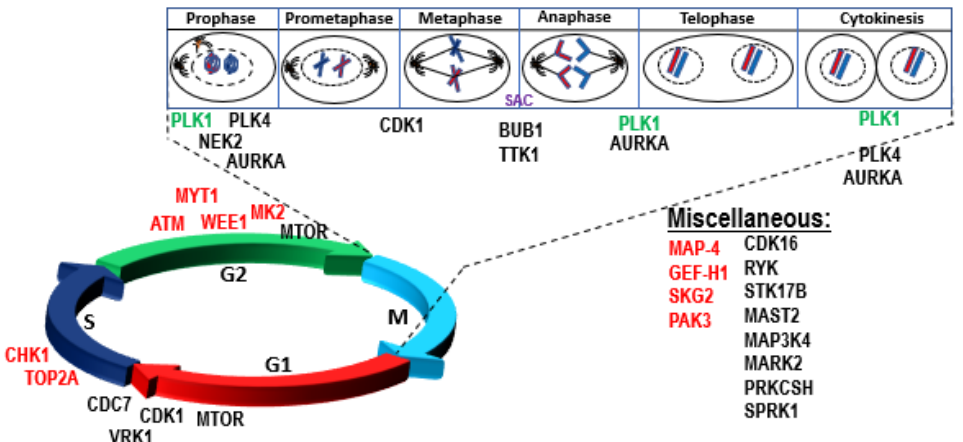
Figure 5. Synthetic lethal interaction of P53 with cell cycle and other genes and their distribution across cell cycle. Experimentally validated or detected in functional genomic screens (red), in silico predicted (black) and both (green). PLK1 = polo-kinase 1, ATM = ataxia telangiectasia mutated, GEF-H1 = guanine nucleotide exchange factor-H1, MK2 = MAP-kinase activated protein kinase 2, SGK2 = serine/threonine kinase, CHK1 = Serine/threonine-checkpoint kinase 1, MAP4 = microtubule-associated protein 4, MYT-1 = Membrane-associated tyrosine- and threonine-specific cdc2-inhibitory kinase, Wee1 = nuclear serine/threonine kinase 1, CDK16 = cyclin-dependent kinase 16, RYK = receptor-like tyrosine kinase, MTOR = mechanistic target of rapamycin, STK17B = serine/threonine kinase 17b, PLK4 = polo-like kinase 4, MAST2 = microtubule associated serine/threonine kinase 2, MAP3K = 4 mitogen-activated protein kinase kinase kinase 4, MARK2 = MAP/microtubule affinity-regulating kinase 2, CDK1 = cyclin-dependent kinase 1, NEK2 = NIMA (never in mitosis gene a)-related kinase 2, PRKCSH = protein kinase C substrate 80K-H, AURKA = aurora kinase A, BUB1 mitotic checkpoint serine/threonine kinase, CDC7 = cell division cycle 7 homolog, SRPK1 = SRSF protein kinase 1, TTK = TTK protein kinase, VRK1 = vaccinia related kinase 1.